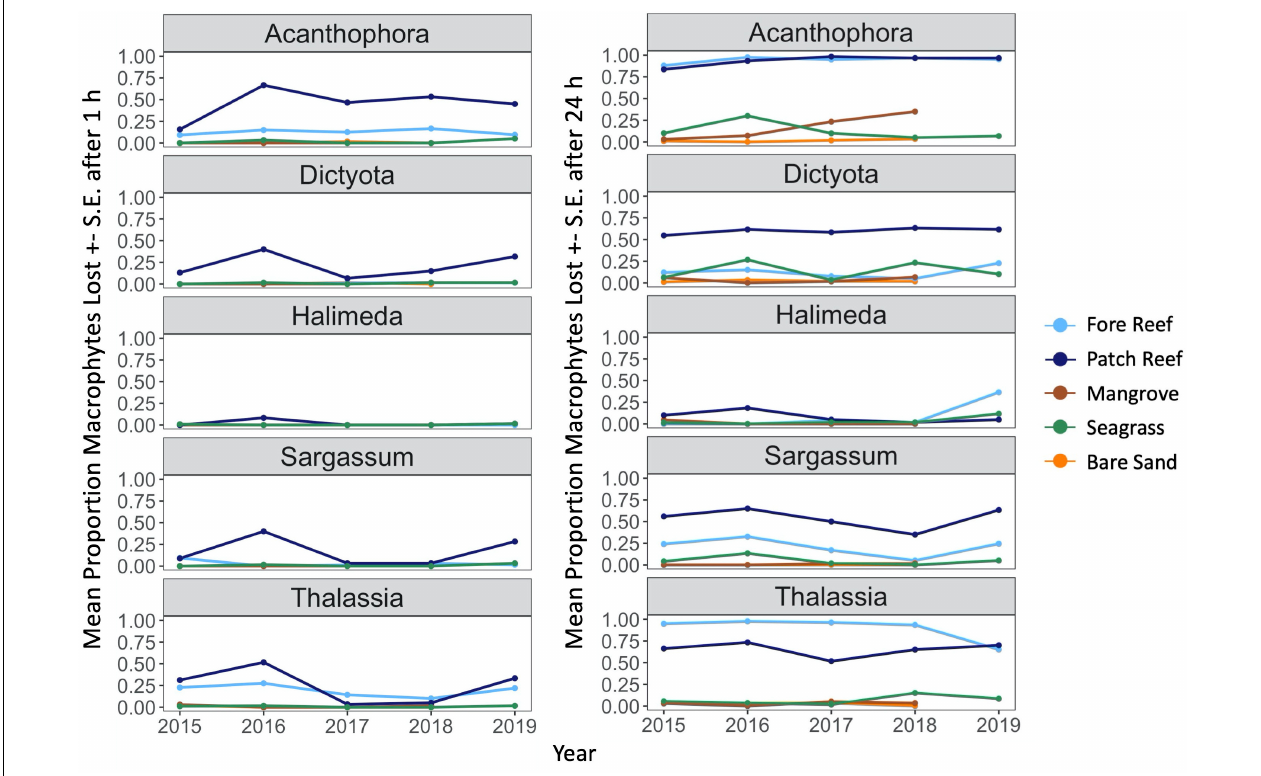
FIGURE 3 | Mean proportion of each macrophyte type consumed after 1 and 24 h ( ± 1 S.E.) across each year of the study, parsed by macrophyte type and habitat.